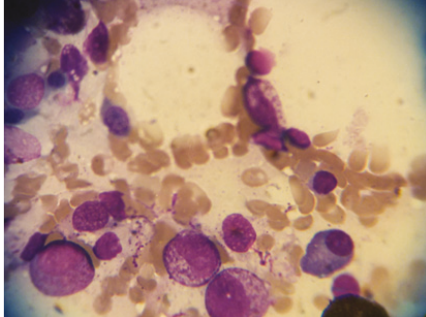
Figure 1: Bone marrow smear at diagnosis showed 70%–80% cellularity with decreased megakaryocyte, increased proportion of myeloid to erythroid cells, and high level of myeloid blasts which could be presumptive of AML-M4.